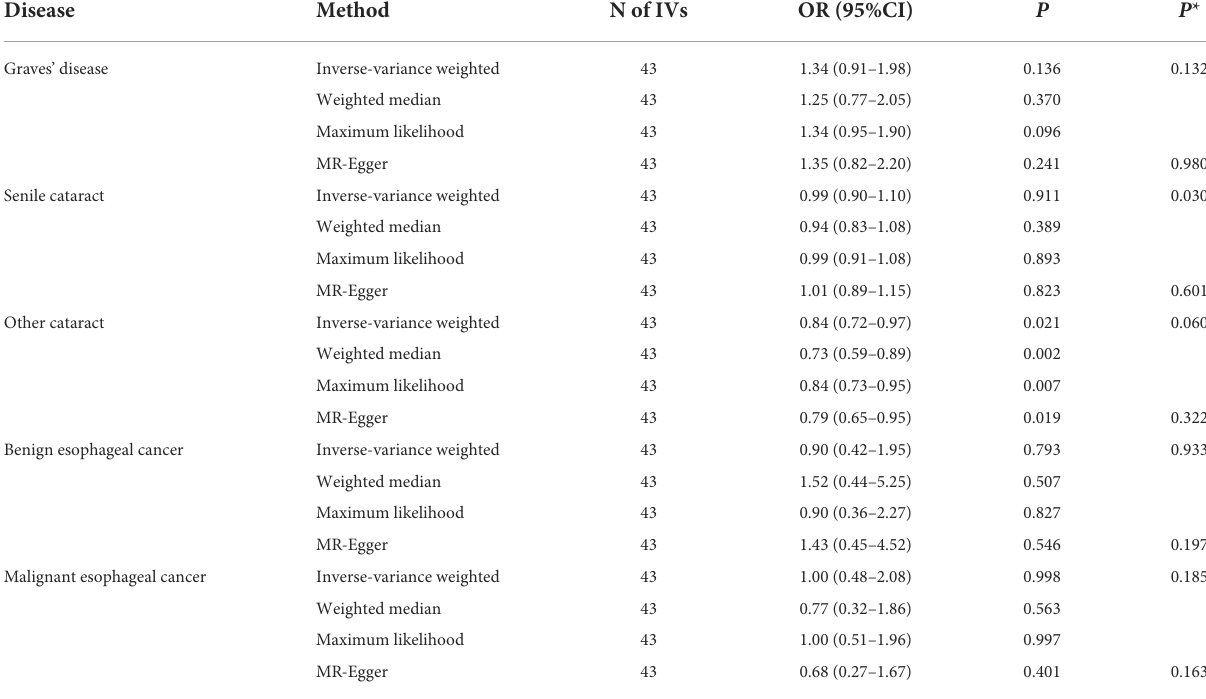
TABLE 3 Causal link between genetically predicted vitamin D in European population and diseases identified in European individuals from FinnGen study.